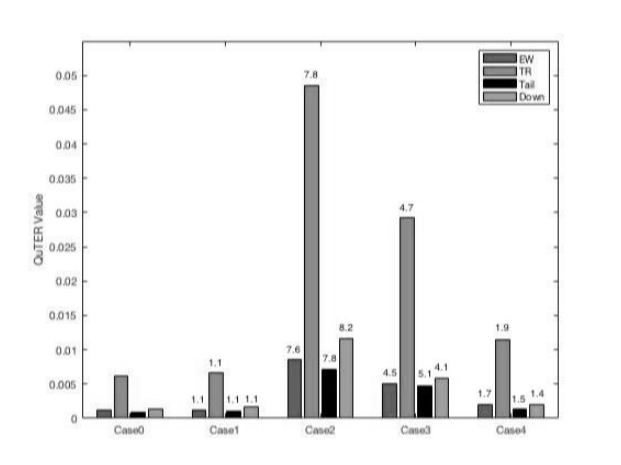
Figure 4. Effect of varying weights on